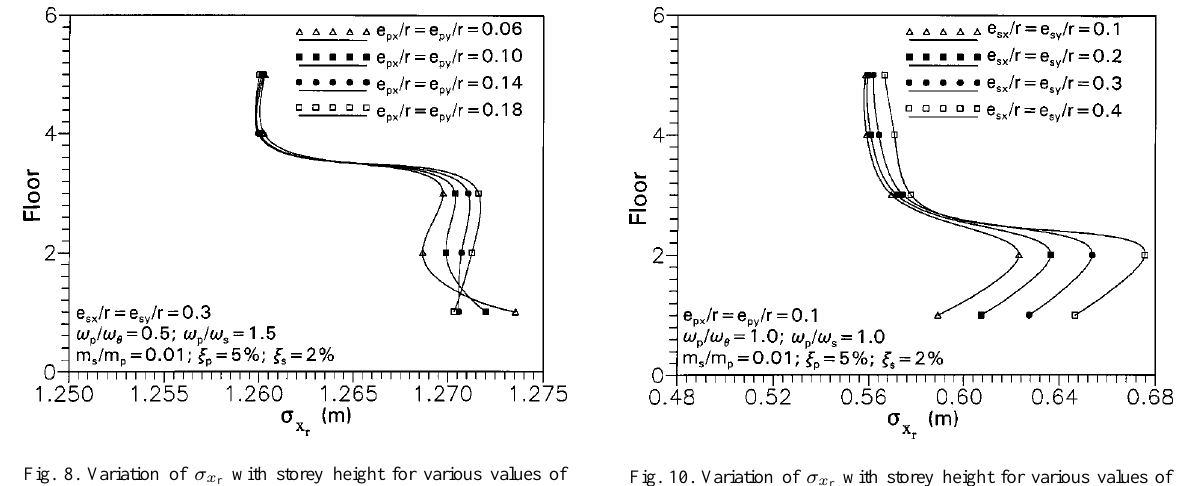
Fig. 10. Variation of (cid:27) x with storey height for various values of r e s x =r and e s y =r ; for m s =m p = 0.01; ! p =! s = 1.0; ! p =! (cid:18) = 1.0; e